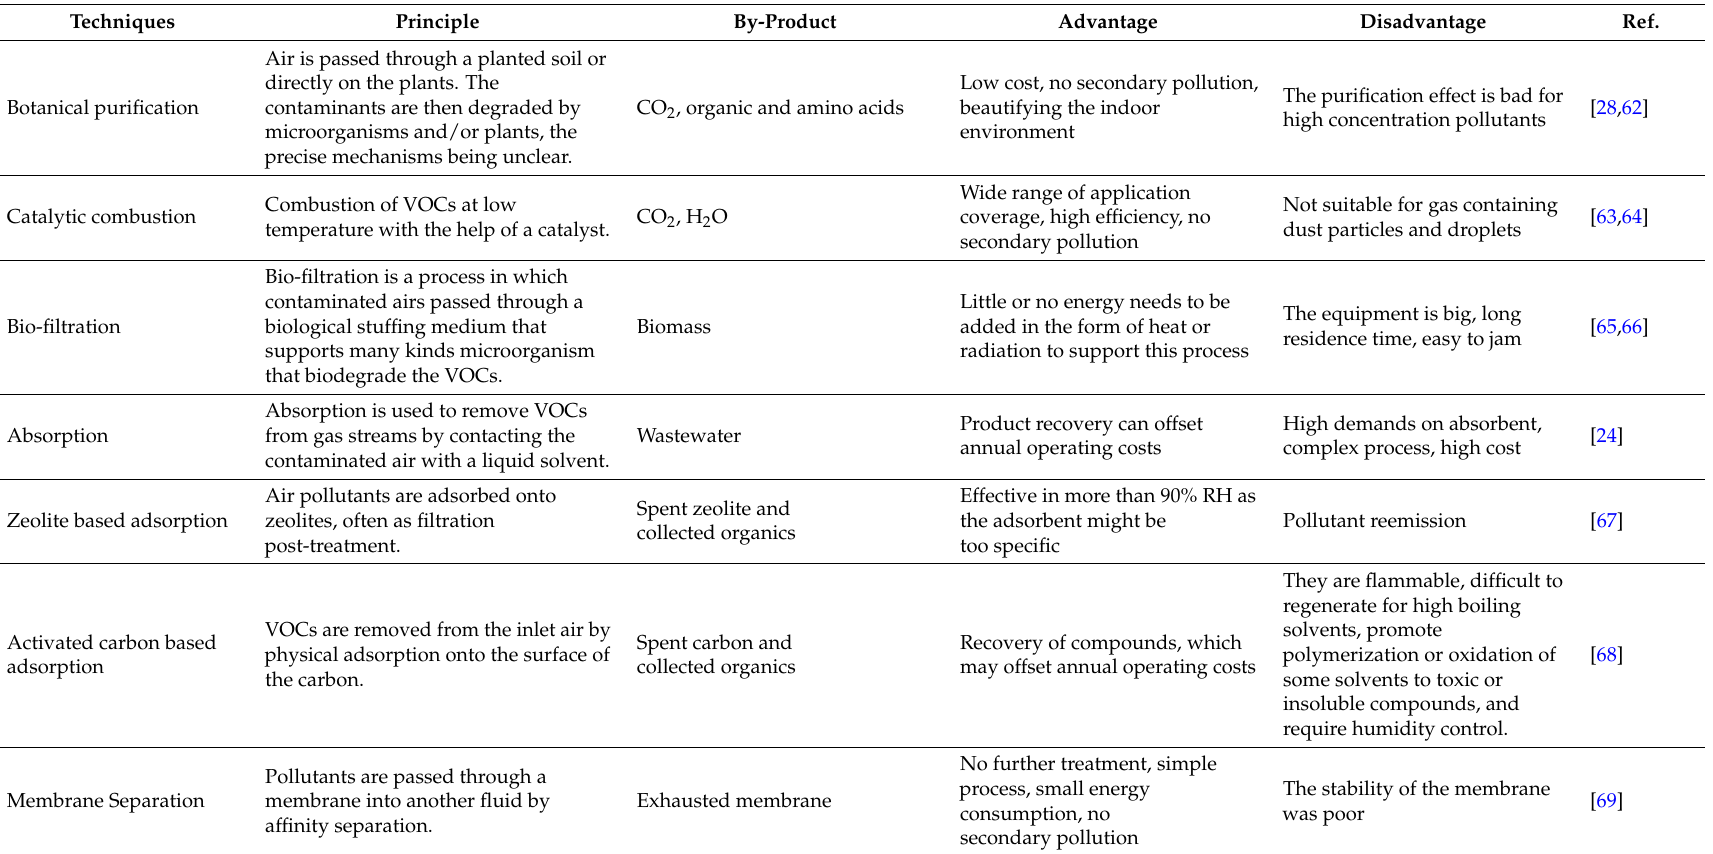
Table 2. Summary on current control techniques for VOCs